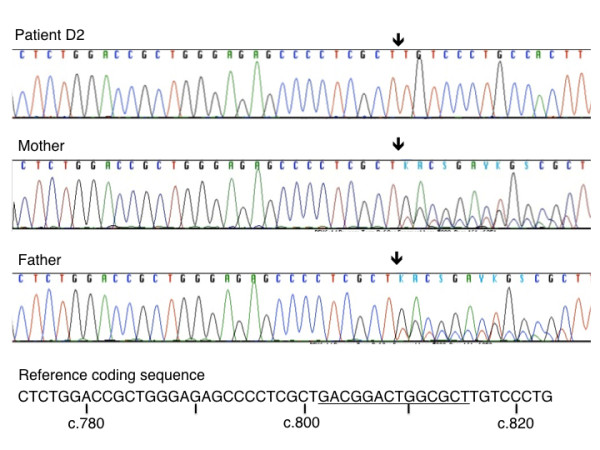
 PEX6 founder mutation c.802_815del. Sanger sequencing traces are shown for patient D2 (homozygote), and his mother and father (heterozygotes). The reference sequence is shown at the bottom with the deleted sequence underlined (Ref Seq NM_000287.3). The arrow indicates the position of the 14-bp deletion. PEX6 exon 1 extends from nucleotides 1–882